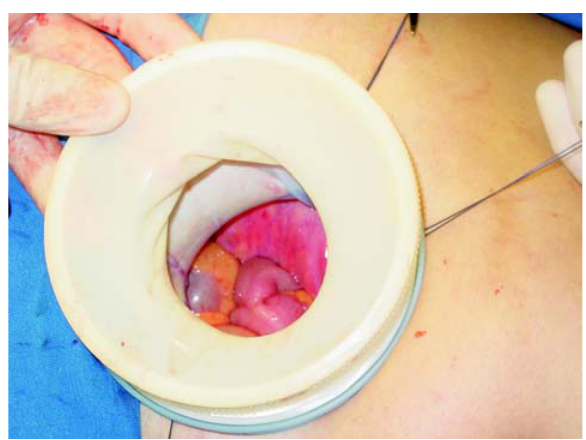
Figure 2 – Placement of the HandPort in the right iliac fossa.